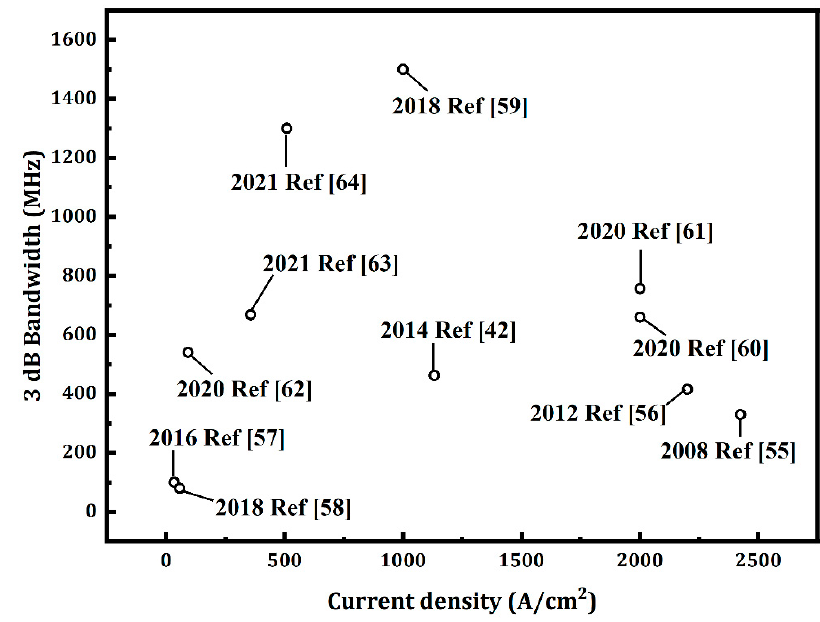
Figure 3. Benchmark for μ -LEDs used in VLC system.